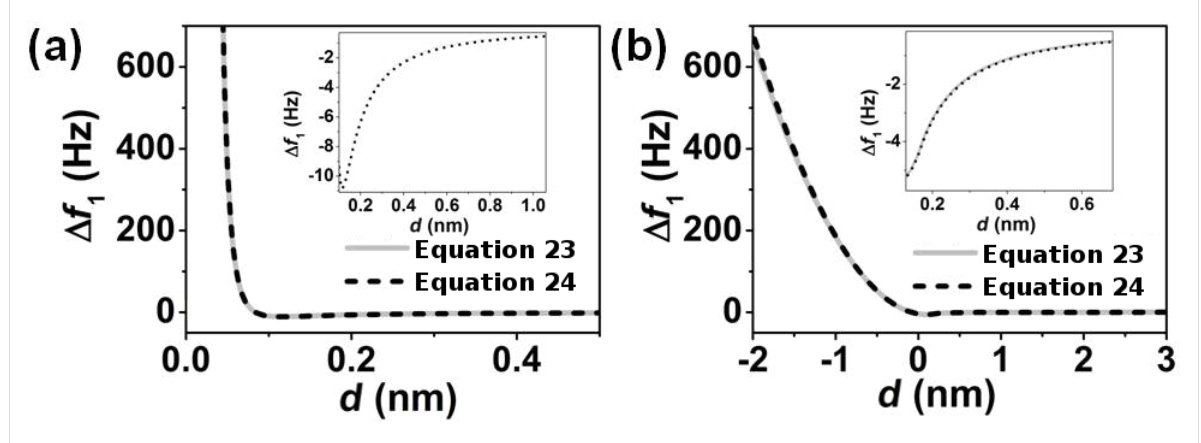
Figure 4: Comparison between the general expression (Equation 23) and the half-integral relationship (Equation 24) to the frequency shift of the first mode in bimodal FM-AFM for two different forces. (a) Lennard-Jones force characterized by ε = 0.5 · 10 − 20 J and σ = 0.1 nm, and A 1 = 4 nm; (b) DMT force characterized by H = 0.2 · 10 − 20 J, E eff = 300 MPa, and A 1 = 10